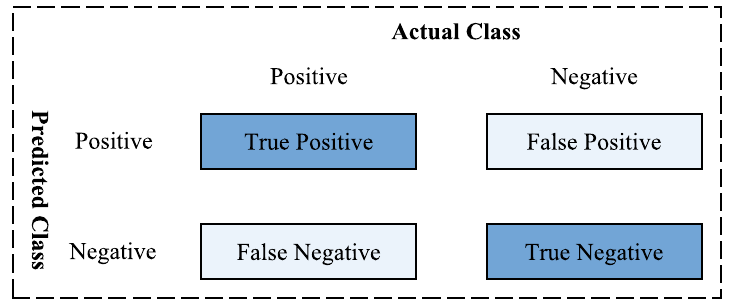
Figure 11. Definitions of true positive, false positive, false negative and true negative 39 . For example, “True Positive” means that one actual positive instance was predicted to be positive by one